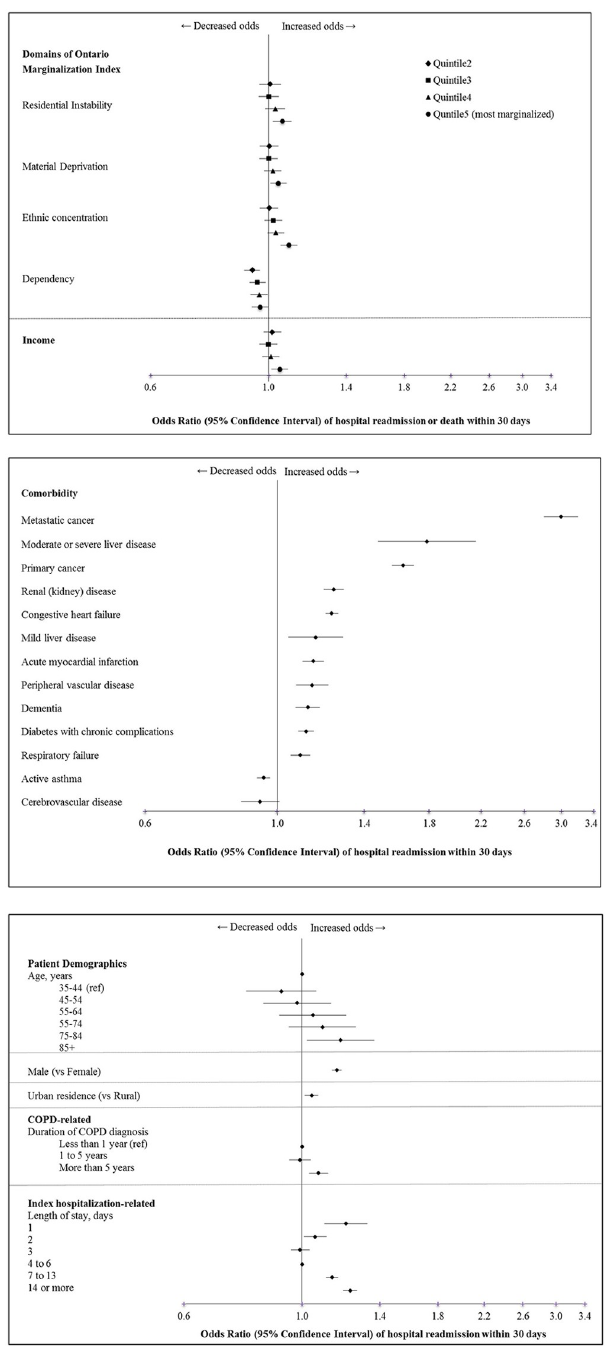
Fig 4. Adjusted odds ratios of A. socioeconomic factors, B. comorbidities and C. patient factors associated with 30-day readmission or death after a COPD